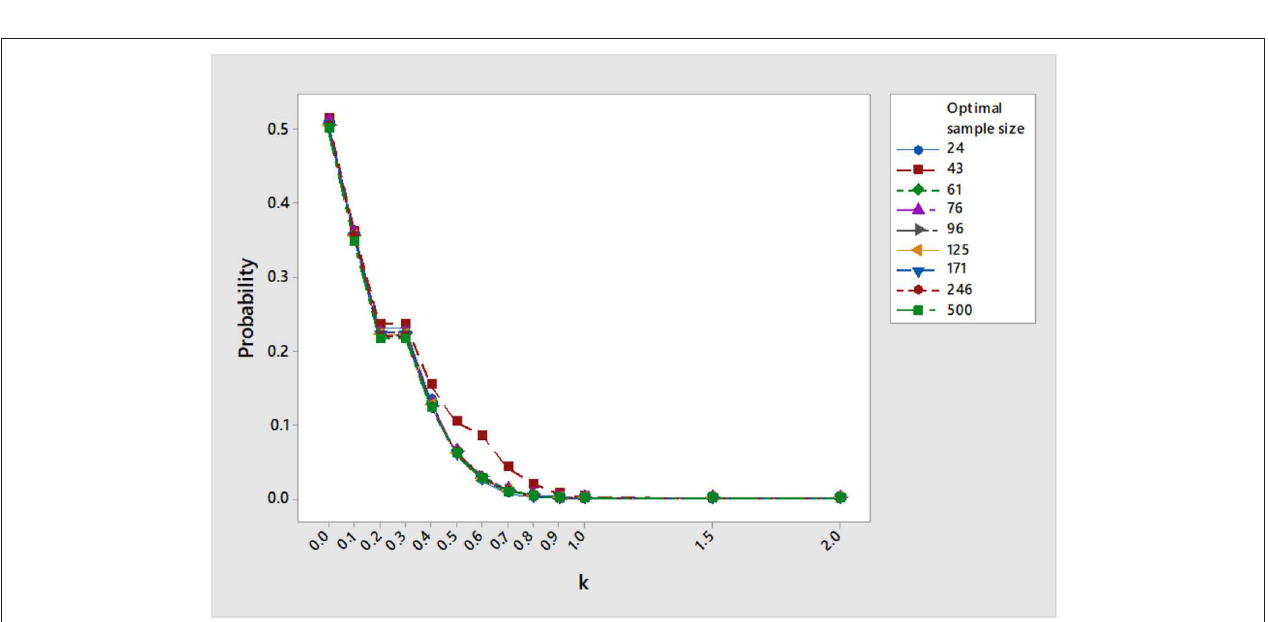
10, σ 5, η 2, γ 0.5, and α 0.05. = = = = =